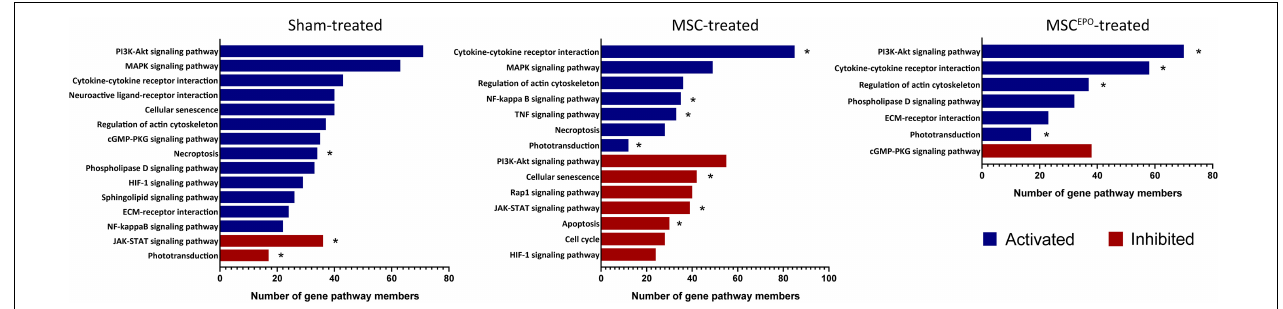
FIGURE 7 | Pathway topology analysis was performed using SPIA with KEGG as the reference database. Phototransduction, which was one of the key pathways of this study, was found to be inhibited in the sham group. In both the MSC and MSC EPO group, however, it was activated. Other notable pathways that were statistically significant in this analysis include necroptosis, apoptosis, JAK-STAT, NF- κ B, TNF, and cytokine-cytokine receptor interactions. Blue bars indicated pathways that have been activated while red bars indicated inhibition (FDR < 0.05, *pGFWER > 0.05).